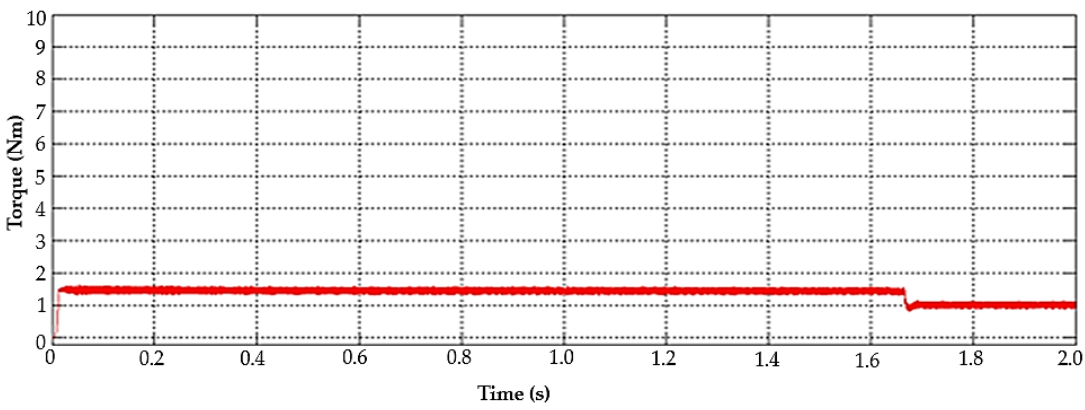
Figure 11. Output load torque characteristics of the BLDC motor before using the LUO converter.